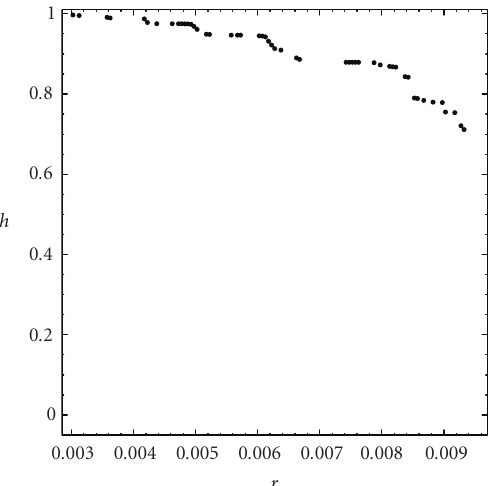
Figure 2.24. Variation of the topological entropy for I = 3 . 25, r ∈ [0 . 0029, 0 . 00965], and s = 4 . 0.